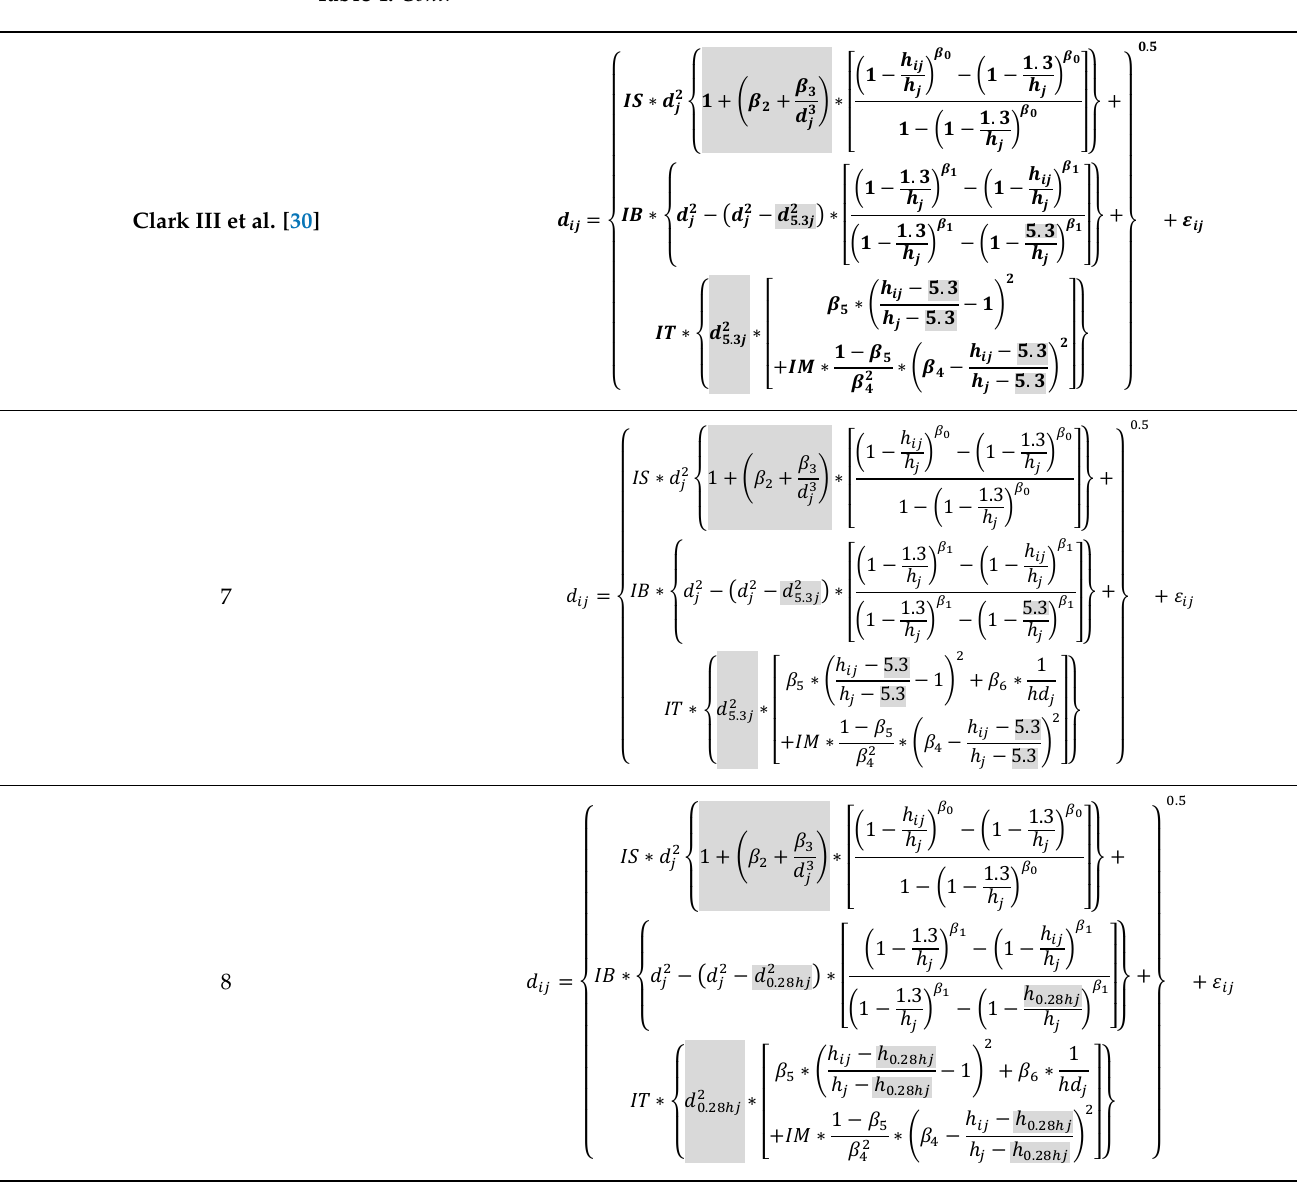
Table 4. Modifications proposed to the Clark III et al. model for the adjustment of data from Tectona grandis L.f., central-west region, Brazil Table 4. Cont.